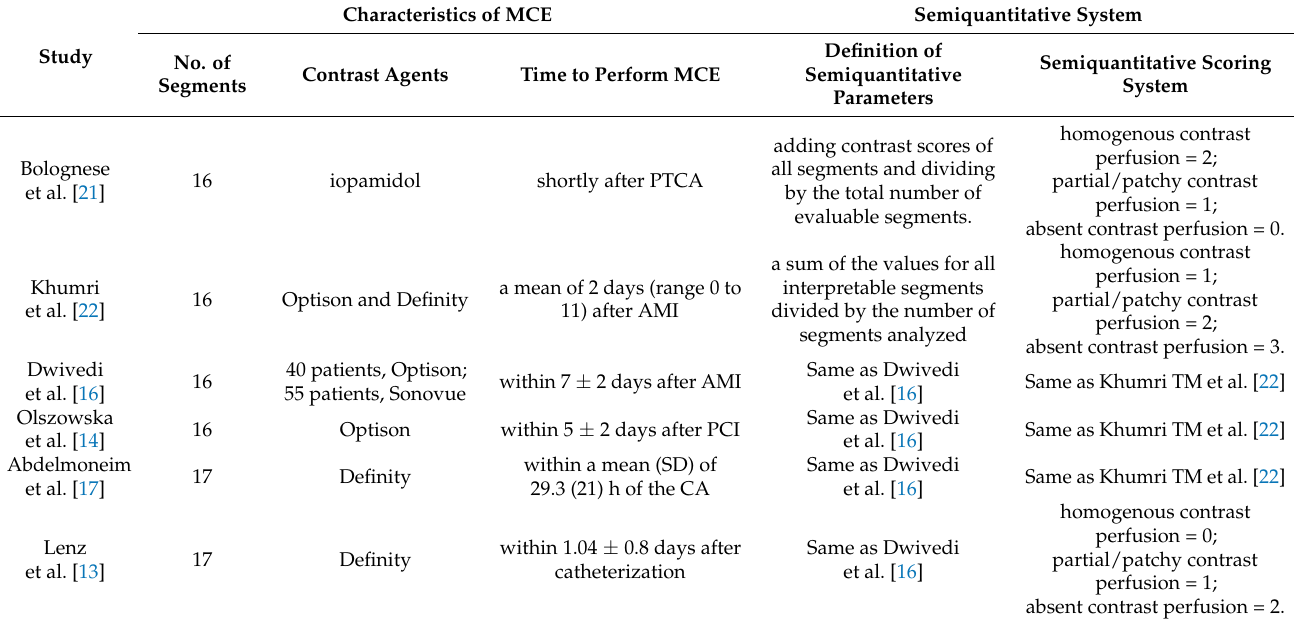
Table 3. Summary of the characteristics of MCE and the Semiquantitative